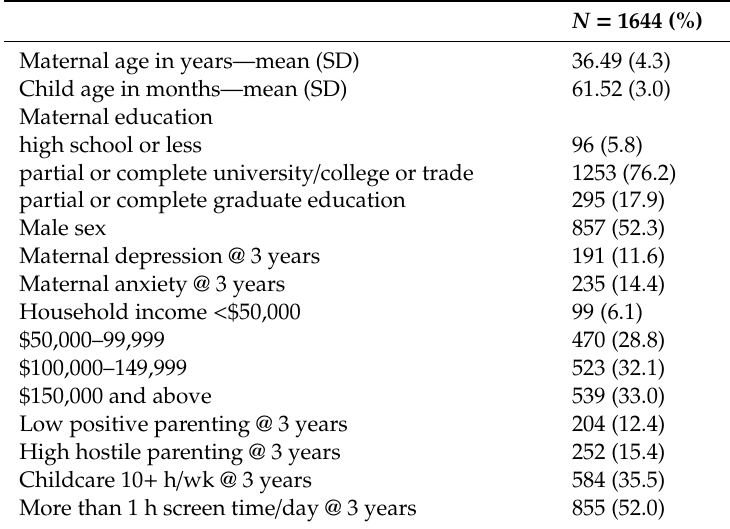
Table 1. Characteristics of children and families.